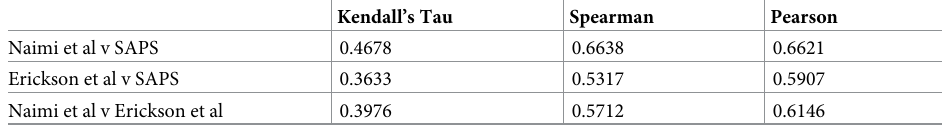
Table 3. Correlation coefficients for the SAPS, Naimi et al and Erickson et al scores, 2009.